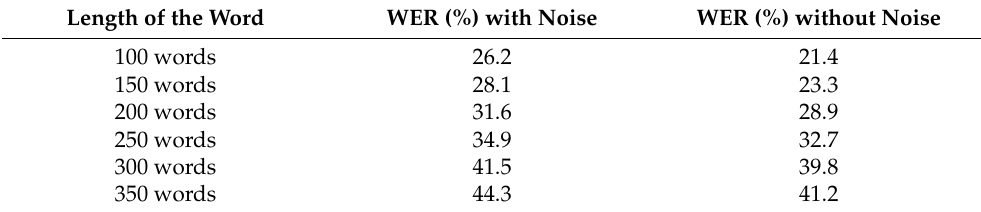
Table 5. WER count and percentage with and without